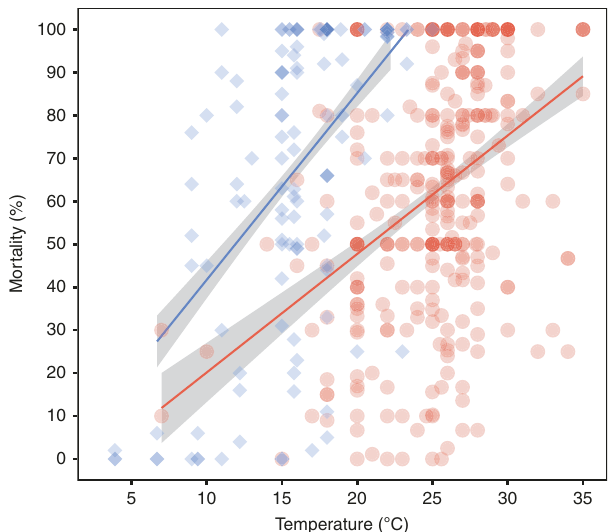
Fig. 1 Predicted changes in mortality (%) of reared aquatic animals infected by bacterial diseases in response to temperature (°C). Bacterial pathogens: Aeromonas spp ., Edwardsiella spp ., F. columnare , Lactococcus spp., Streptococcus spp., Vibrio spp ., and Yersinia spp . Red indicates tropical and subtropical host species ( n = 329), blue indicates temperate host species ( n = 129). Dots represent the raw data and the lines the linear mixed model predictions with